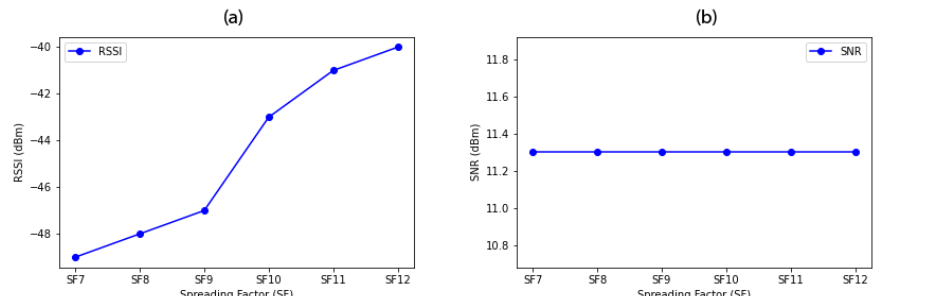
Figure 21. Result of LoRaMESH scenario (a) RSSI and (b) SNR for packages sent by SMs or